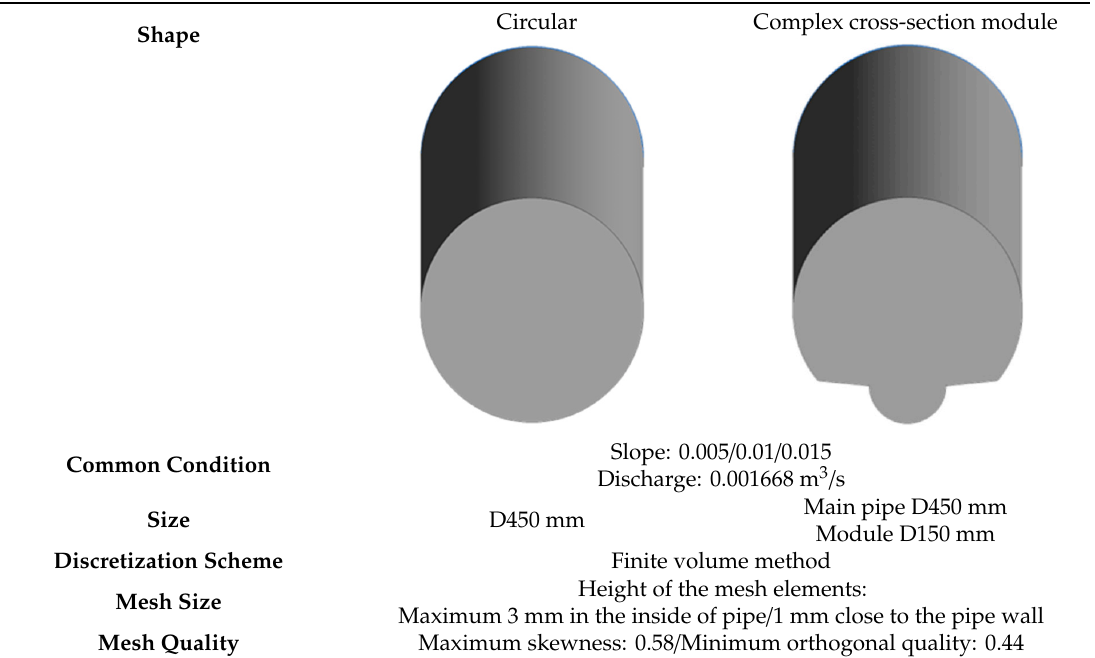
Table 2. Domain and condition for numerical modeling.